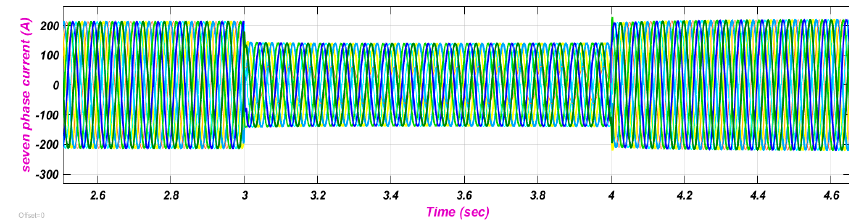
Figure 9. Fault Current of 7 P IG with One Phase Open ( V c ).